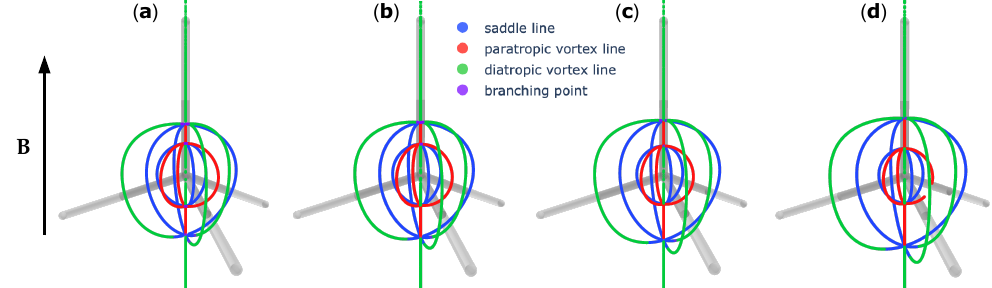
Figure 3. The stagnation graphs of the CH 4 molecule in its equilibrium geometry with a magnetic field of ( a ) 0.05 B 0 , ( b ) 0.10 B 0 , ( c ) 0.15 B 0 and ( d ) 0.20 B 0 along the z -axis, arranged from left to right, respectively. The interactive version of these figures may be found in CH4_B005.html , CH4_B010.html